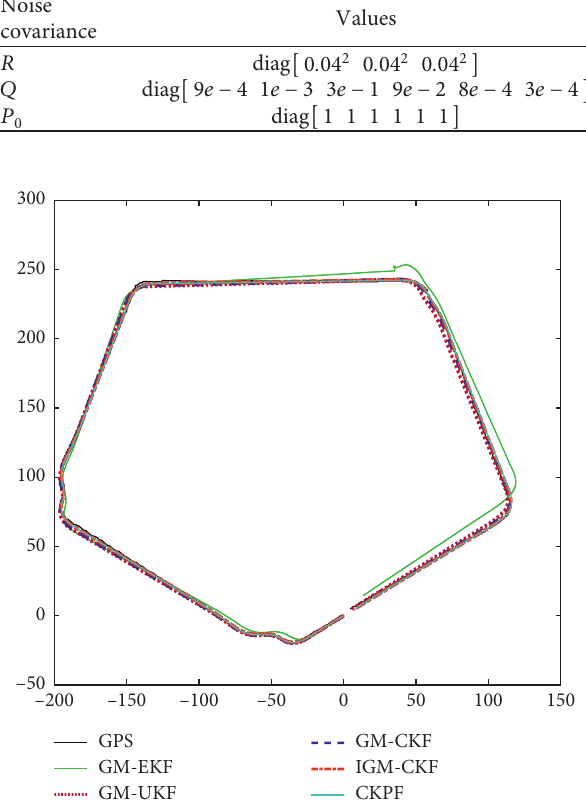
Figure 3: Comparison of the trajectory estimations based on 1,450 data points.